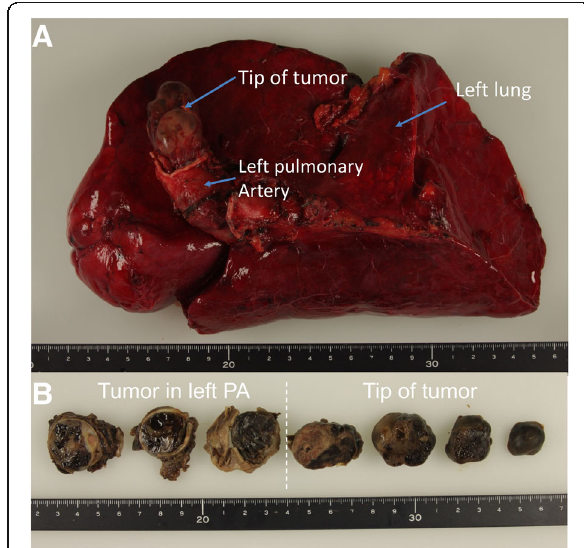
Fig. 4 a Pathological specimen, including the tumor, the left pulmonary artery (PA), and the left lung. b The cross section of the tumor was 1 cm in thickness. The mass protruded about 3 cm into the right PA and filled the left